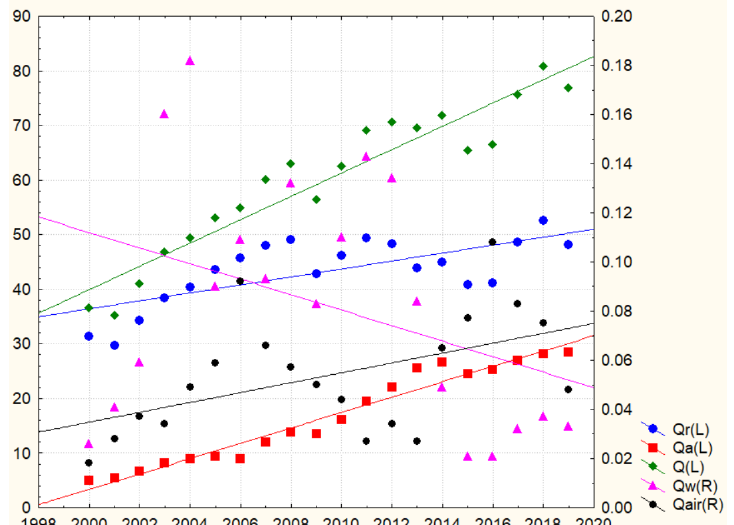
Figure 5: Dynamics of changes in cargo turnover by means of transport, billion ton-km, and approximating straight lines